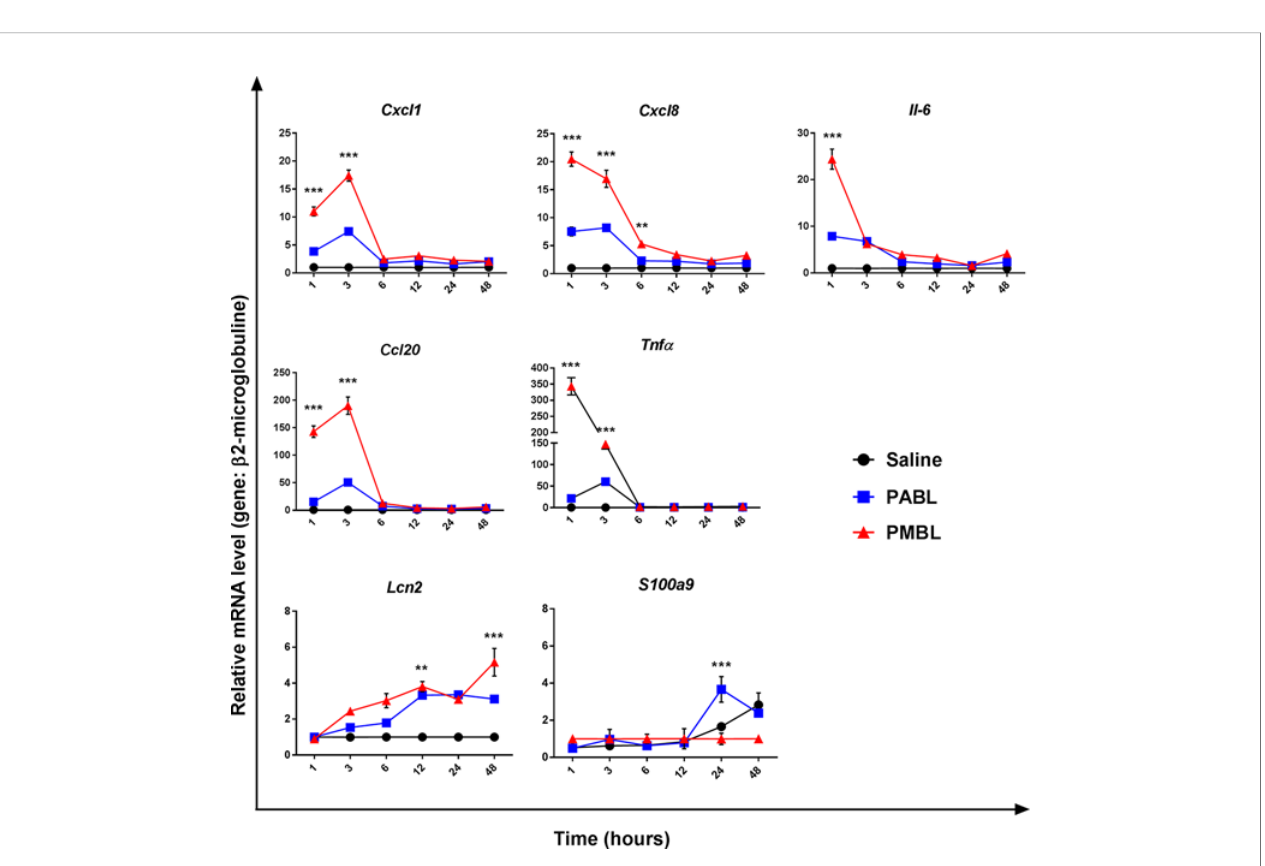
FIGURE 2 | Temporally kinetics of the transcriptional pro fi le of the alveolar cell line (A549) in vitro stimulated with 10 m g/ml of either PABL or PMBL for 1, 3, 6, 12, 24 or 48 h. Relative mRNA levels of Ccl20, Cxcl1, Cxcl8, Tnfa, Il6 and Lipocalin 2 were assessed by RT-qPCRs. Data are expressed as fold increase of relative mRNA levels for each gene normalized against b 2-microglobulin referred to non-stimulated cultures. Each point represents Mean ± SEM of quintuplicate cultures. Data are representative of three independent experiments. Signi fi cant differences between groups are indicated by **p < 0.01 and ***p < 0.001, two-way ANOVA with Bonferroni correction.